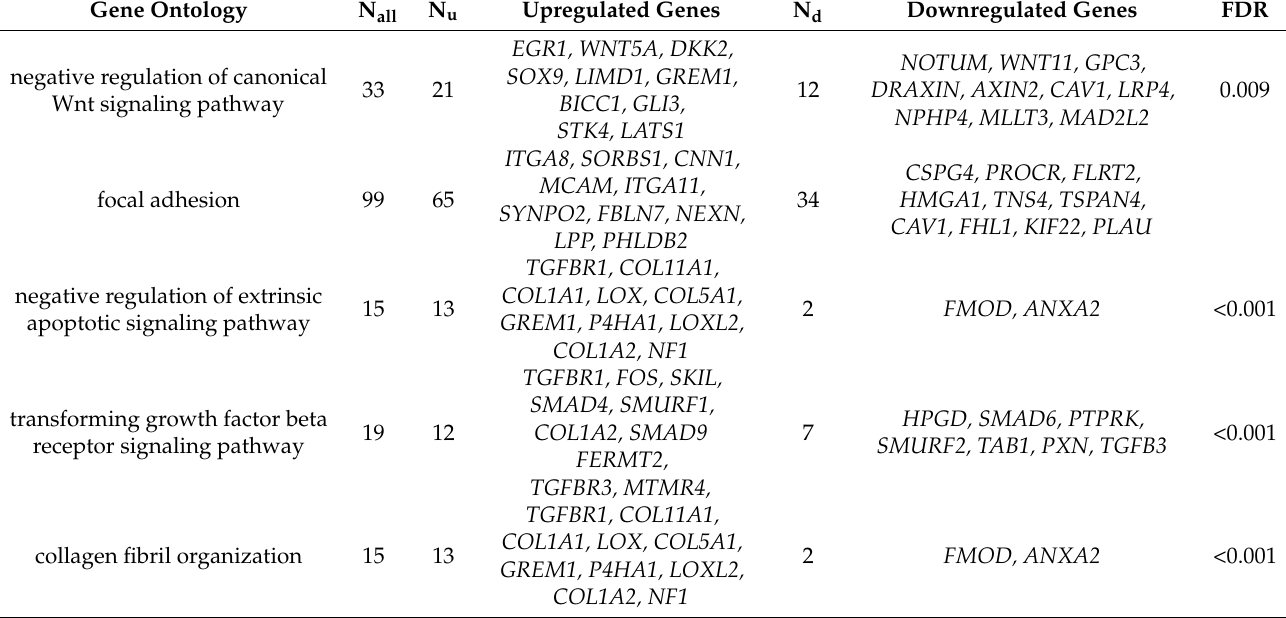
Table 2. The significant enrichment in Gene Ontology terms detected on the basis of comparative analysis of DEGs set between BPV-E1ˆE4 and control group.